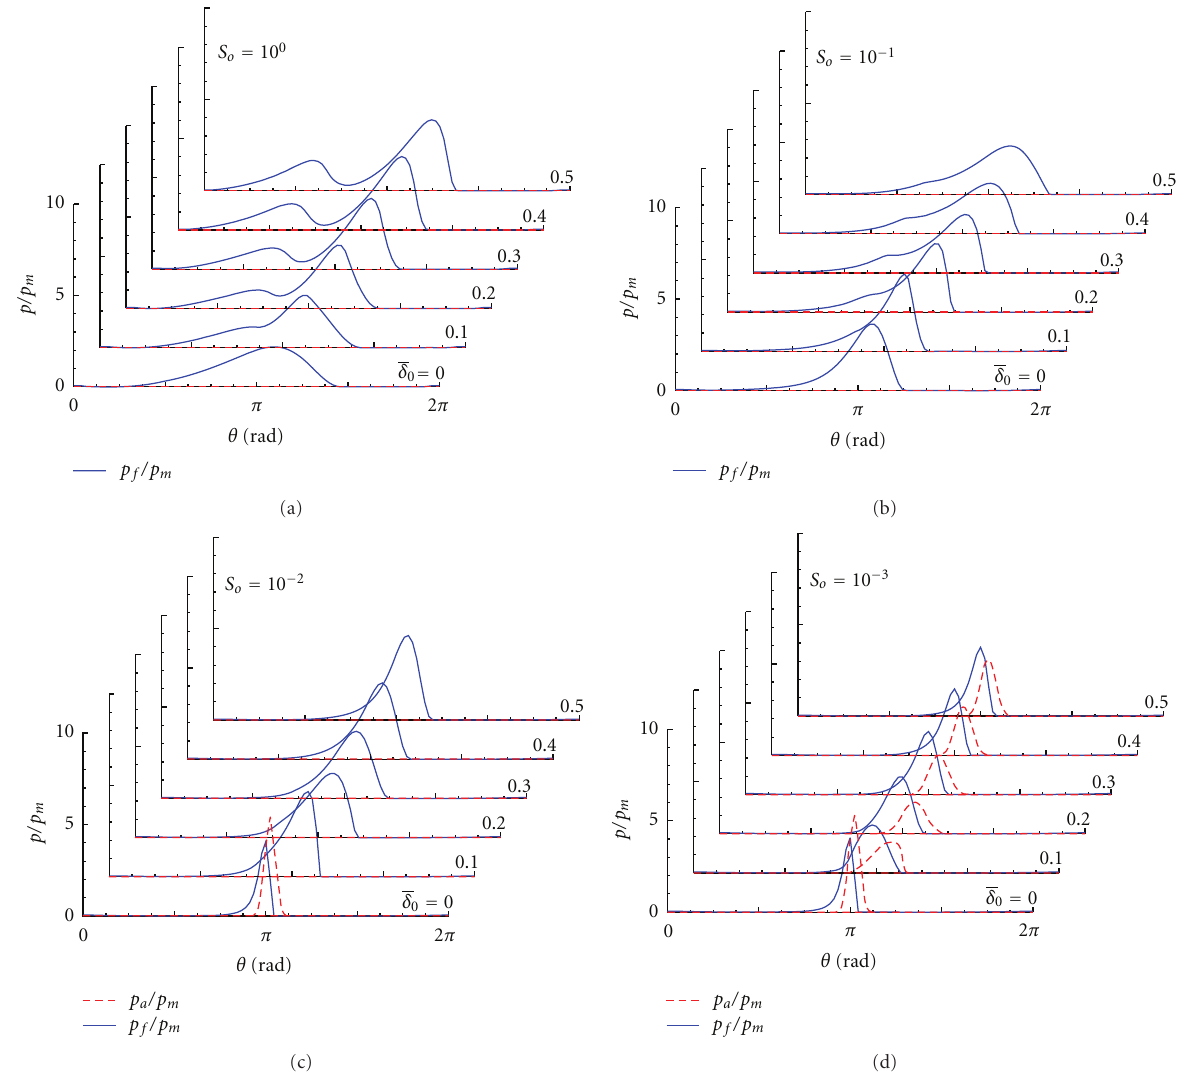
Figure 3: (a) Distributions of fluid pressures p contact pressures p and fluid pressures p a